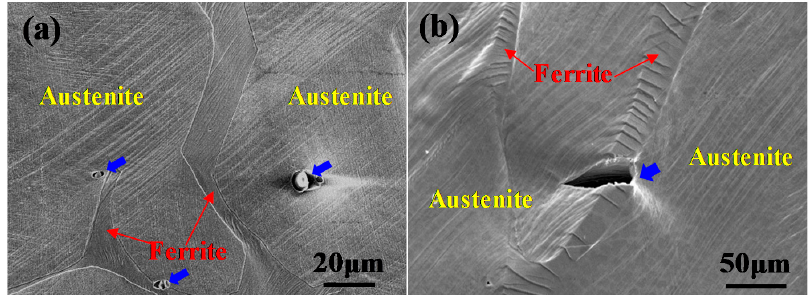
Figure 8. Deformation characteristics of austenite and ferrite phases near the tensile fracture of the ( a ) un-aged and ( b ) aged specimens.